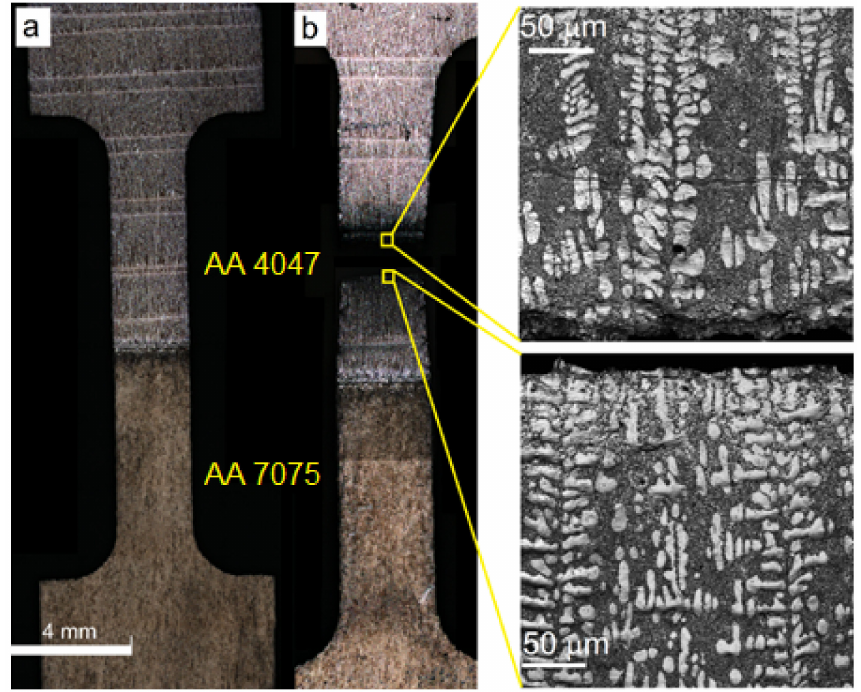
Figure 14. Tensile sample before ( a ) and after ( b ) fracture with dendritic structures in the vicinity of fracture. The fracture occurred in the as-deposited AA4047 zone where there were no compo- nents other than Al-dendrites, excess Si-crystallites and Al/Si eutectics. It could be that Si-crystallites (shown inside the yellow circles in Figure 15a,b) served as stress concentra- tors, but this as-cast structure was heterogeneous enough by itself. The fracture surface is characterized by the presence of dimples, ridges and ~3 µ m cells (Figure 15a,b). Despite the fact that no deformation neck formed, the fracture may be related to the viscous